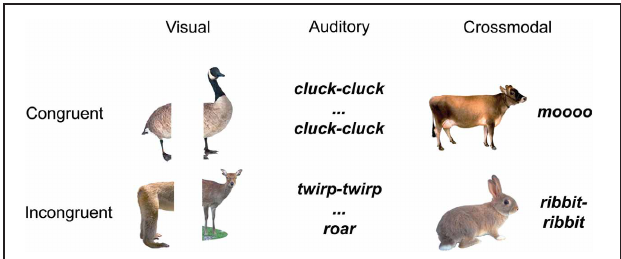
FIGURE 1 | Example stimuli belonging to the living things